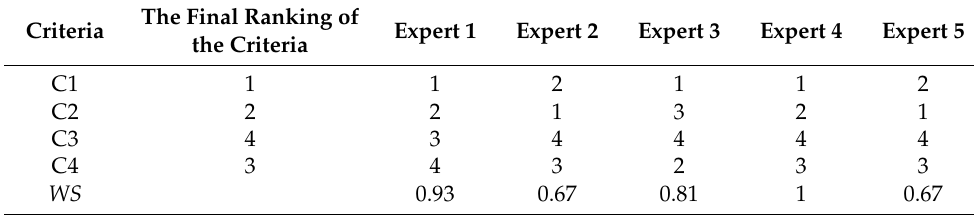
Table 7. The WS coefficients of the criteria.